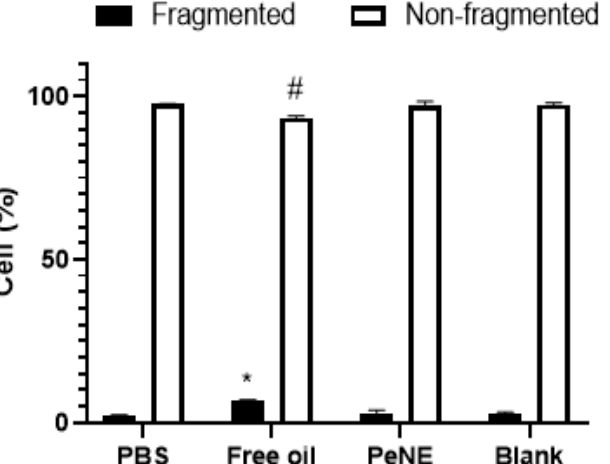
Figure 4. Cytotoxicity of pequi oil-based nanoemulsion (PeNE), free pequi oil, and the blank (egg lecithin without oil) formulation at 90, 180 and 360 µ g/mL on the viability of macrophage cells (J774.16) after exposure for 24 h. The control group was treated with PBS. The assay was carried out using the MTT method. The values are expressed as mean ± SEM. One-way ANOVA: significant difference compared to the control group * p < 0.05, *** p < 0.001, and **** p < 0.0001. The concentrations of 180 and 360 µ g/mL were chosen to evaluate the genotoxicity of free pequi oil and PeNE, respectively, on J774.16 cells through the analysis of the DNA fragmentation pattern of treated cells. Figure 5 shows that PeNE did not induce signif- icant DNA fragmentation after 24 h of exposure. Free pequi oil induced a slight DNA fragmentation of 6.5% ( p < 0.05) when compared to the control group.